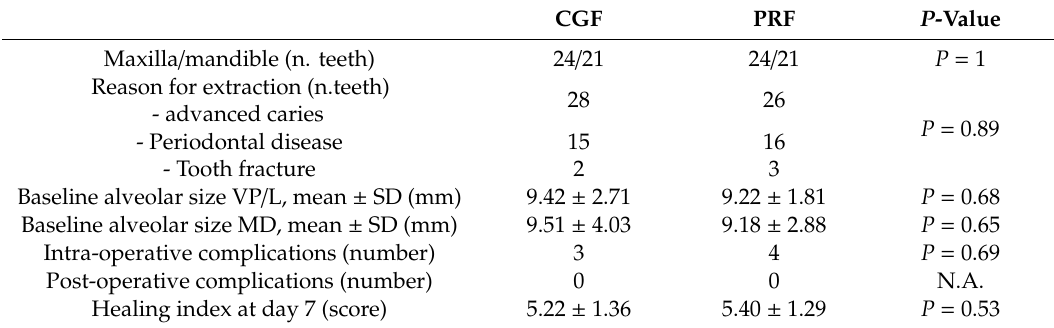
Table 1. Characteristics of the patients and outcomes in the two groups. CGF PRF P -Value Maxilla / mandible (n. teeth) 24 / 21 24 / 21 P = 1 28 26